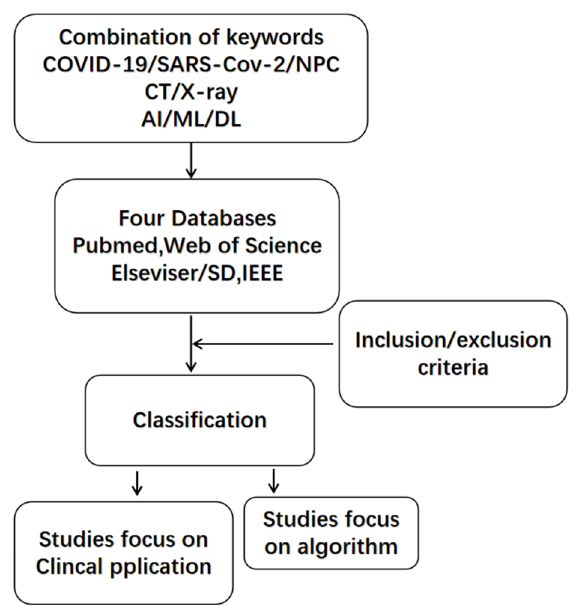
Figure 3. Flowchart of selection and exclusion.